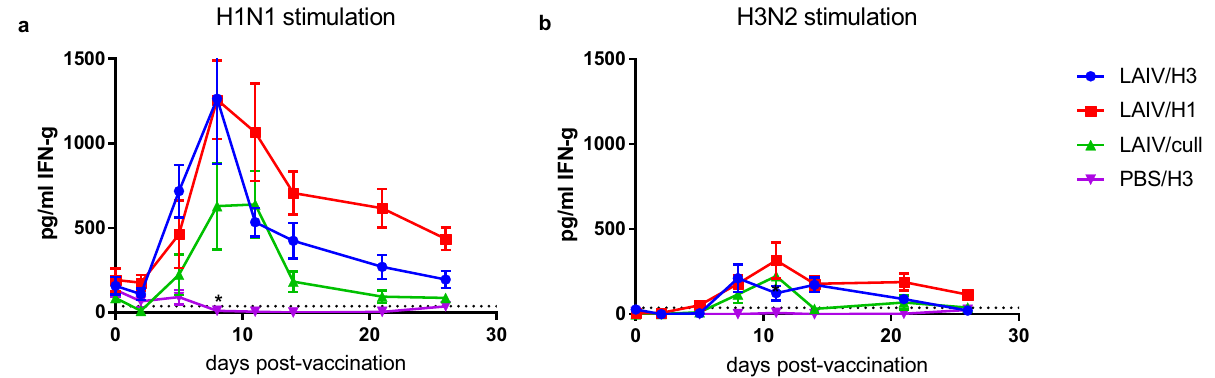
Fig. 3 Cellular immune responses to vaccination with LAIV. IFN- γ response in antigen-stimulated whole blood was determined by ELISA. Blood was stimulated with wild-type ( a ) H1N1 or ( b ) H3N2 viruses. Points show mean and standard error. The black line (All LAIV) shows the mean of all LAIV-vaccinated ferrets. The dotted horizontal line shows the limit of quantitation. *PBS/H3 group was signi fi cantly lower than the vaccinated groups on ( a ) day 8 and ( b ) day 11 (Mann – Whitney test, P < 0.0001, n =